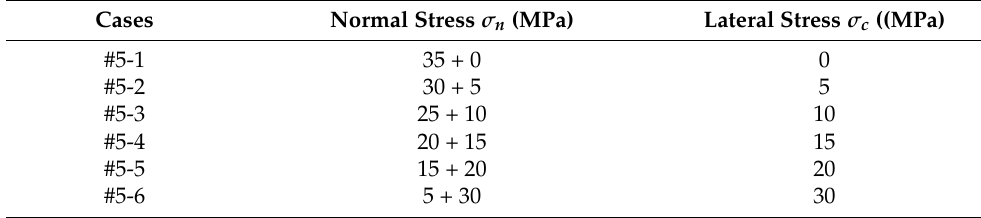
Table 2. The normal compression test loading scheme.